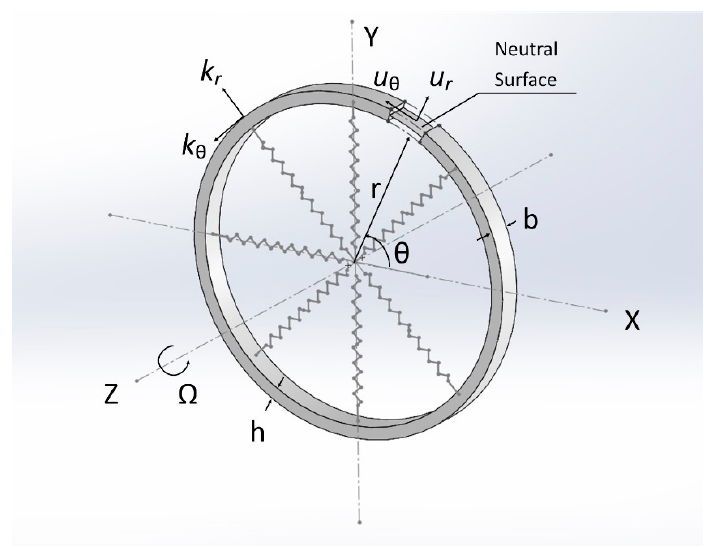
Figure 1. Schematic of ring geometry.